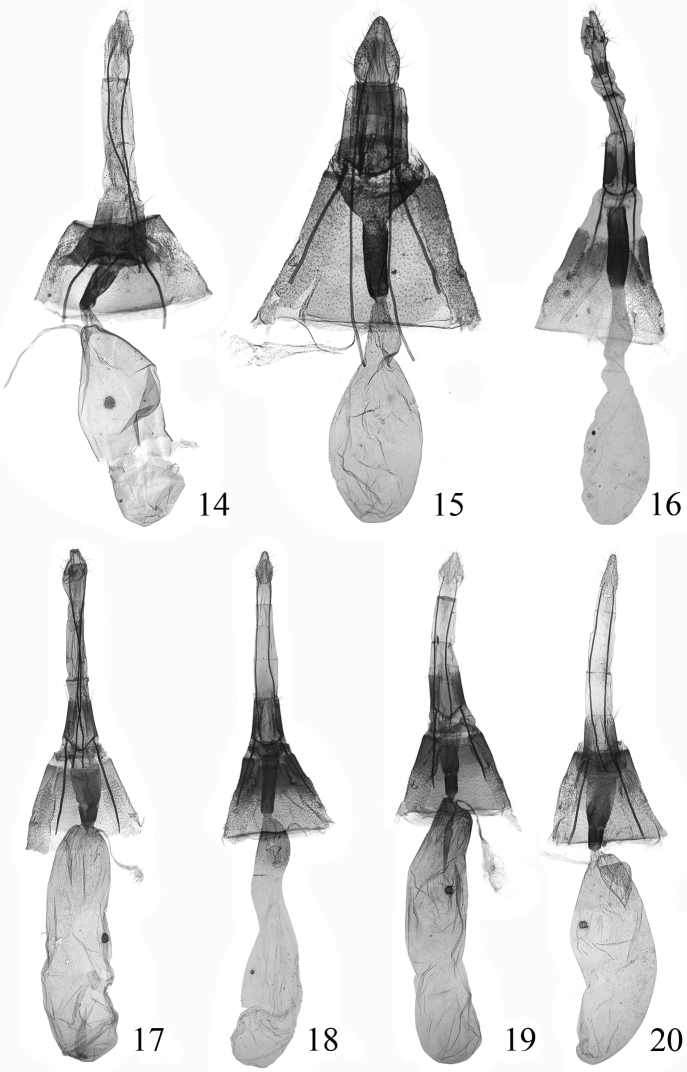
Female genitalia of spp. 14
Endotricha dentiprocessa sp. n., paratype, slide no. SYL1103015
Endotricha unicolor sp. n., paratype, slide no. SYL1100316
Endotricha shafferi sp. n., paratype, slide no. SYL11024 17
Endotricha convexa sp. n., paratype, slide no. SYL11112 18
Endotricha hoenei Whalley, 1963, slide no. SYL1110919
Endotricha luteogrisalis Hampson, 1896, slide no. SYL11099 20
Endotricha simipunicea Wang & Li, 2005, slide no. SYL11097.